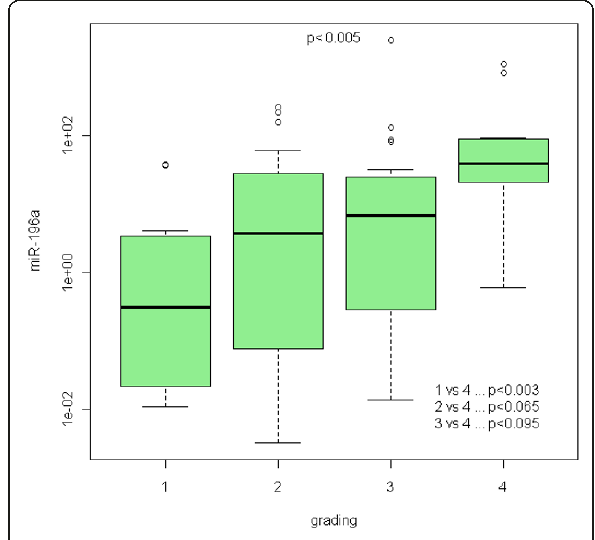
Figure 5 Rising miRNA-196a upregulation in BE patients in NBI detected BE(1), BE(2), low-grade dysplasia(3), high-grade dysplasia/adenocarcinoma(4)